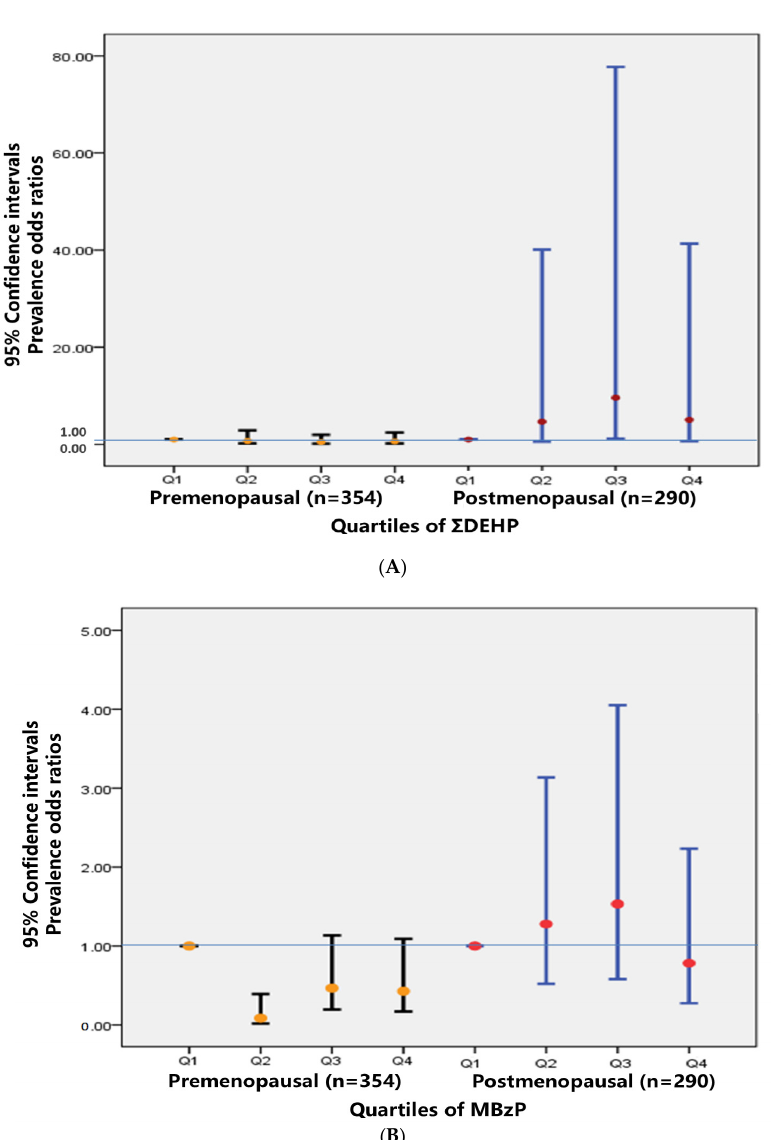
Figure 1. ( A ) Prevalence odds ratios for the association between urinary ∑ DEHP metabolites concentrations and metabolic syndrome stratified by menopausal status in females. ( B ) Prevalence odds ratios for the association between urinary MBzP concentrations and metabolic syndrome stratified by menopausal status in females. Prevalence odds ratios adjusted for urinary creatinine, age, education, and working status.